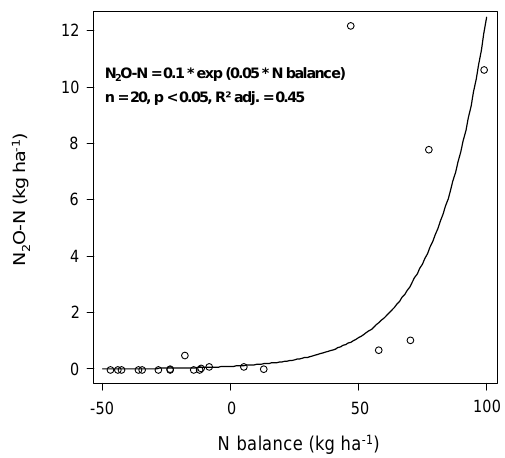
Figure 9. Relationship of cumulated N 2 O fluxes ( n = 8) for a cer- tain period of the growing seasons 2012 and 2013 at the arable site (AR) to nitrogen balance ( n = 3) for the same period, calculated from mineral N input of mineral and organic fertilizers and the N removal by plants. R 2 adjusted was estimated for predicted vs. ob- tained